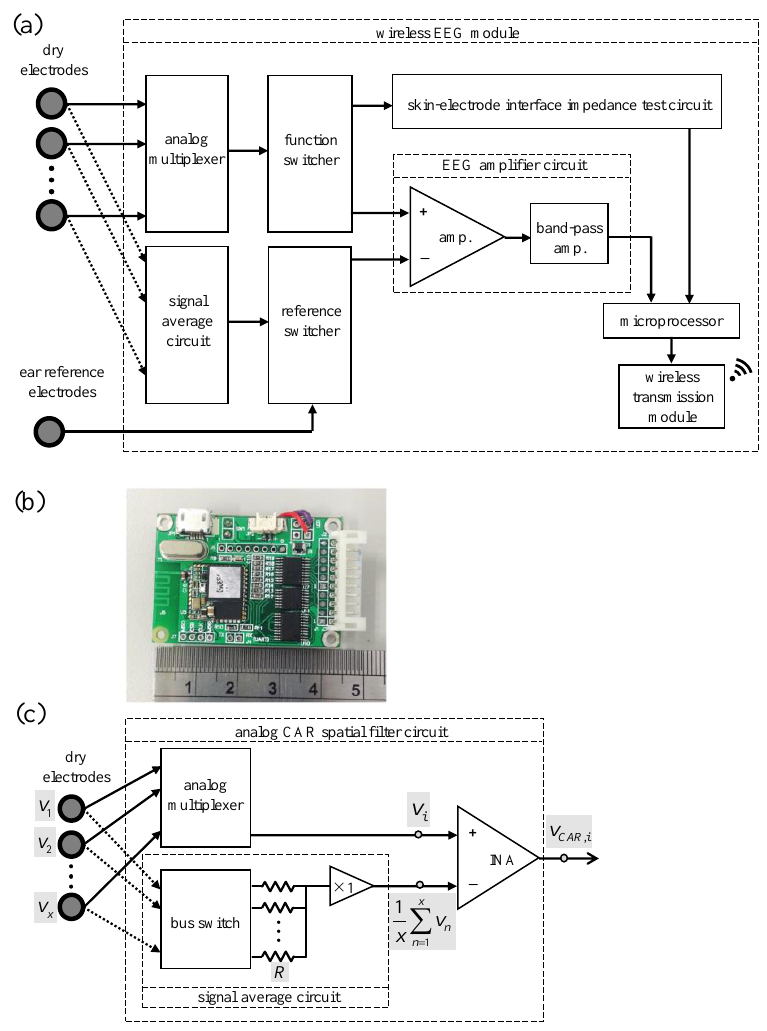
Figure 3. Block diagram ( a , b ) photograph of proposed wireless EEG acquisition module; and ( c ) basic schematic of analog CAR spatial filter circuit.